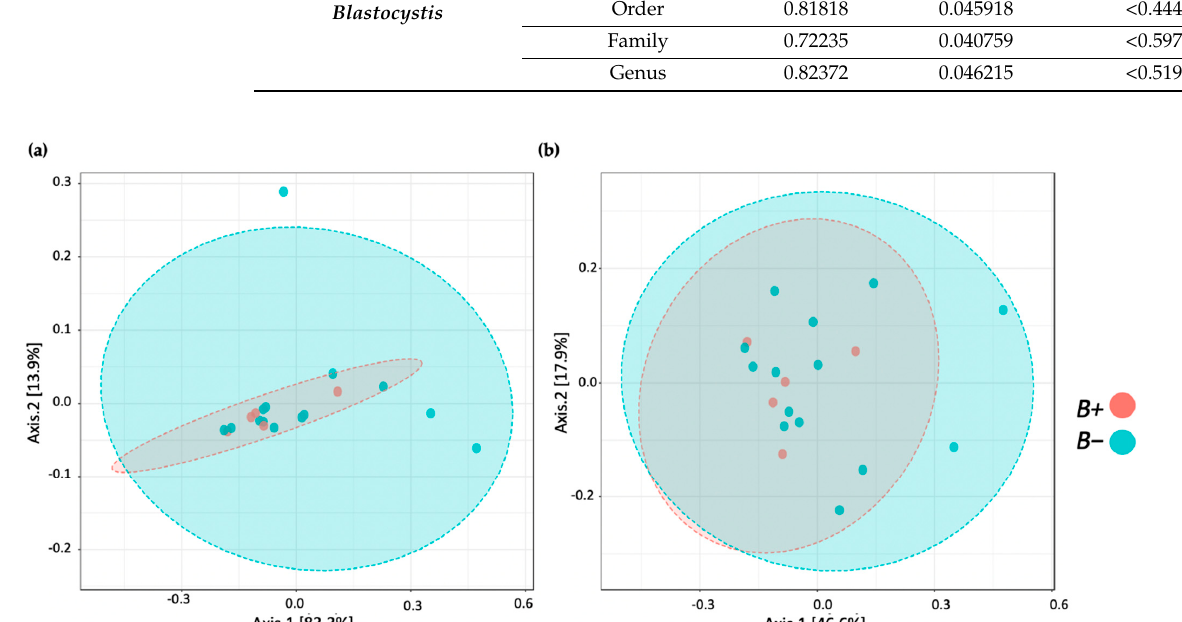
Figure A1. Principal Coordinate Analysis (PCoA) plots of the beta diversity of B + voles (red) and B - voles (blue) based on Bray-Curtis dissimilarity index ( a ) shows the Beta-diversity PCoA plot at the phylum level and ( b ) shows the Beta-diversity PCoA at the genus level.